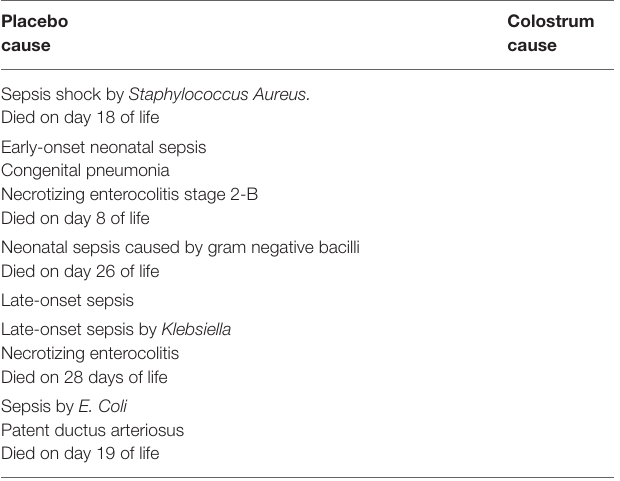
TABLE 4 | Patients who participated at the study and causes of death. Placebo cause